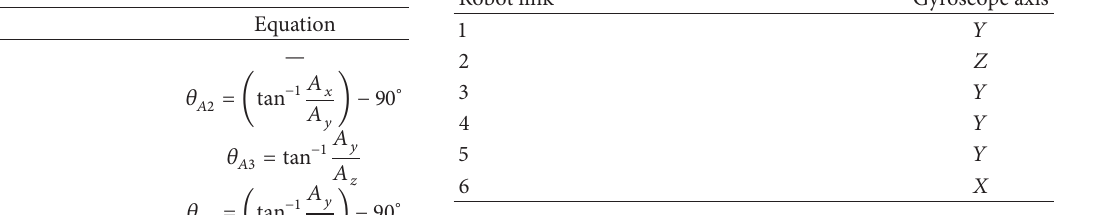
Table 2: Equations to estimate the angular position of each joint using accelerometers.